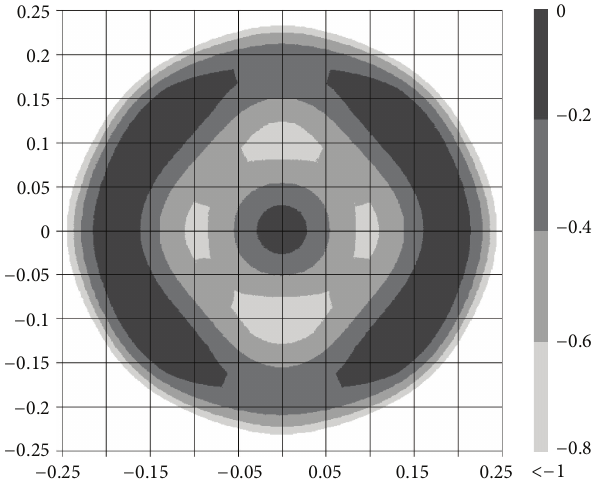
Figure 9: Ripple of the 8 × 8 planar array with a circular radiation pattern in the u - v plane (expressed in dB).